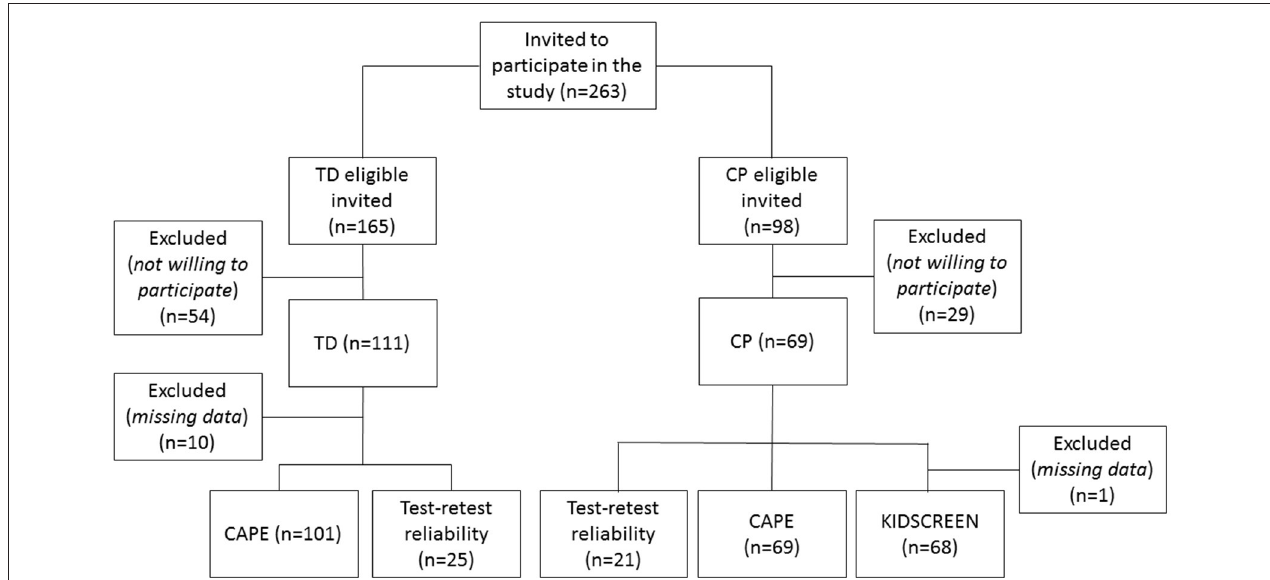
FIGURE 1 | Flow chart of the recruitment for the study.